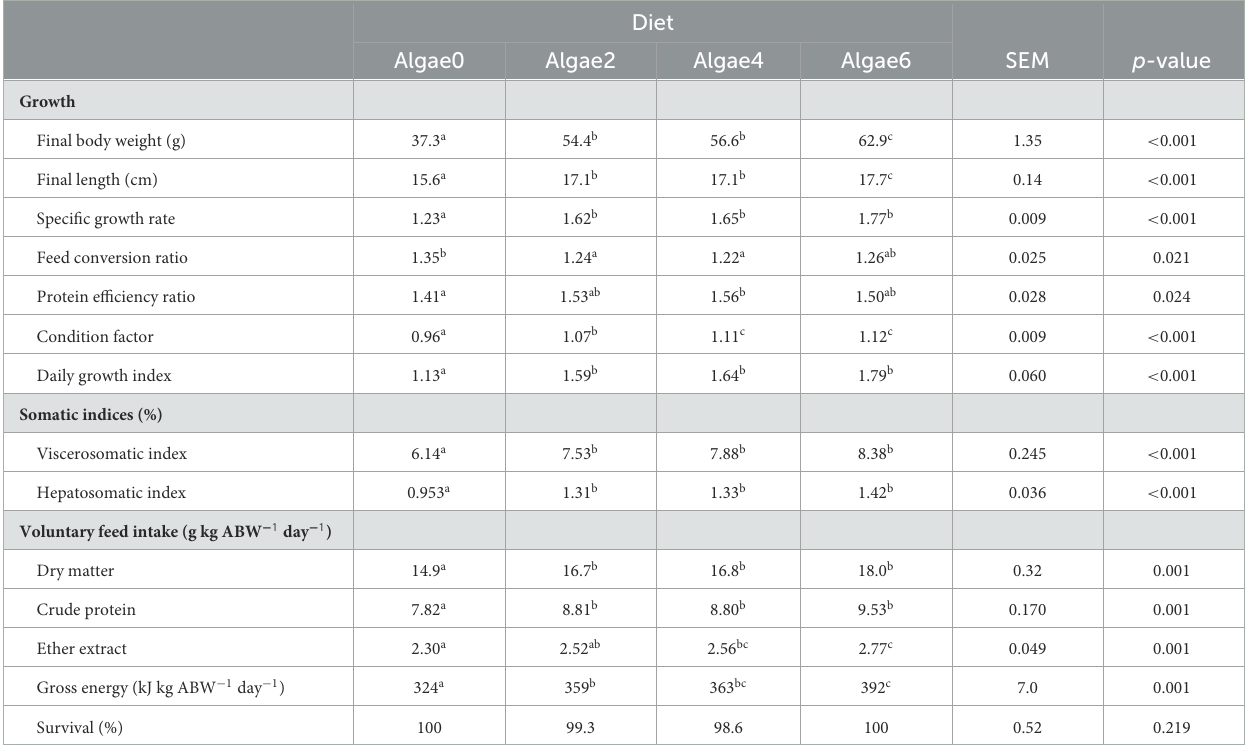
TABLE 4 Growth performance and feed utilization of European seabass juveniles fed the experimental diets. Diet Algae0 Algae2 Algae4 Algae6 SEM p- value